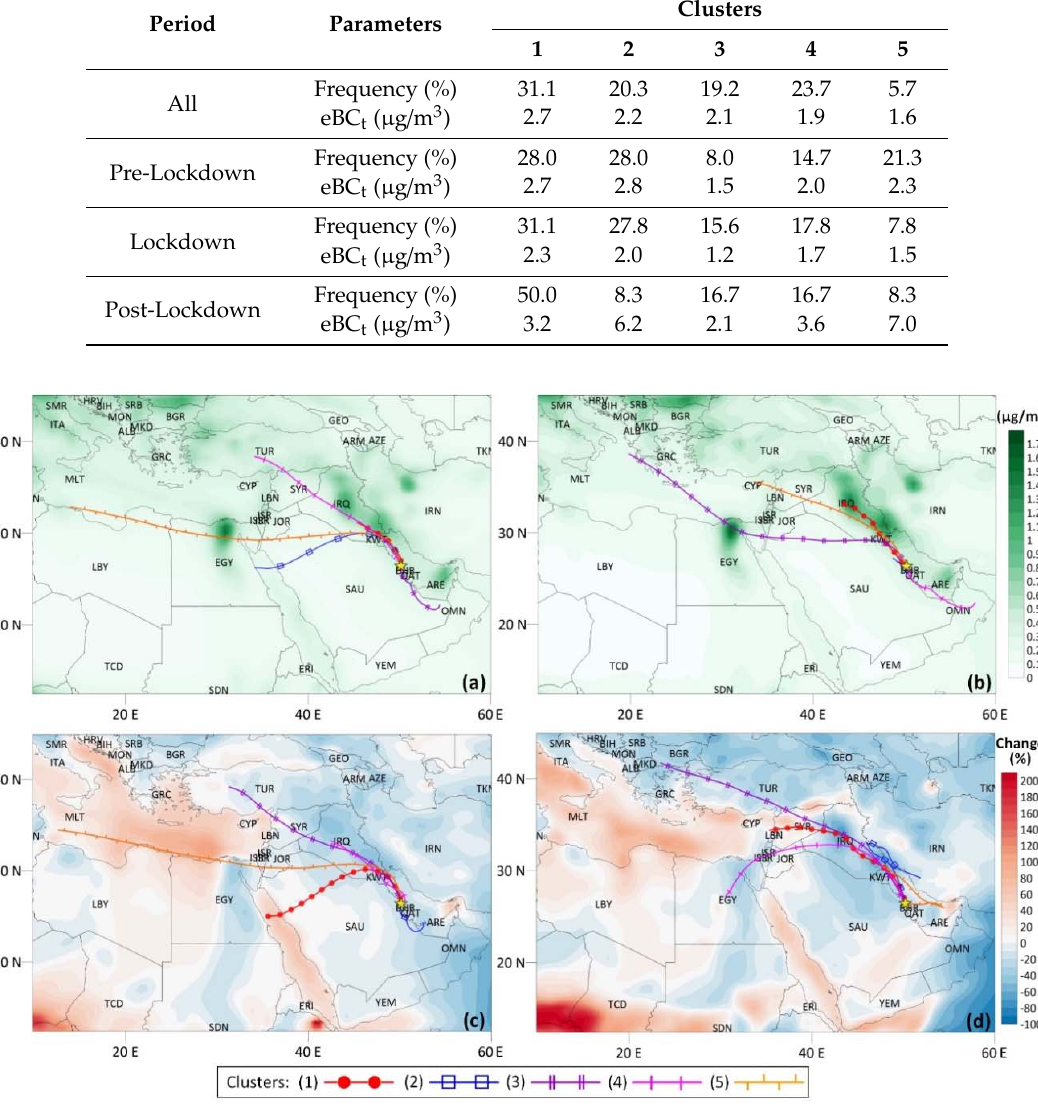
Figure 6. Clusters of three ‐ day backward trajectories superimposed on satellite ‐ based total BC (BCt) surface data along ( a ) the entire study and ( b ) Pre ‐ LD periods with mass concentrations; ( c ) LD and ( d ) Post ‐ LD periods with percent change in mass concentrations as compared to the Pre ‐ LD period.